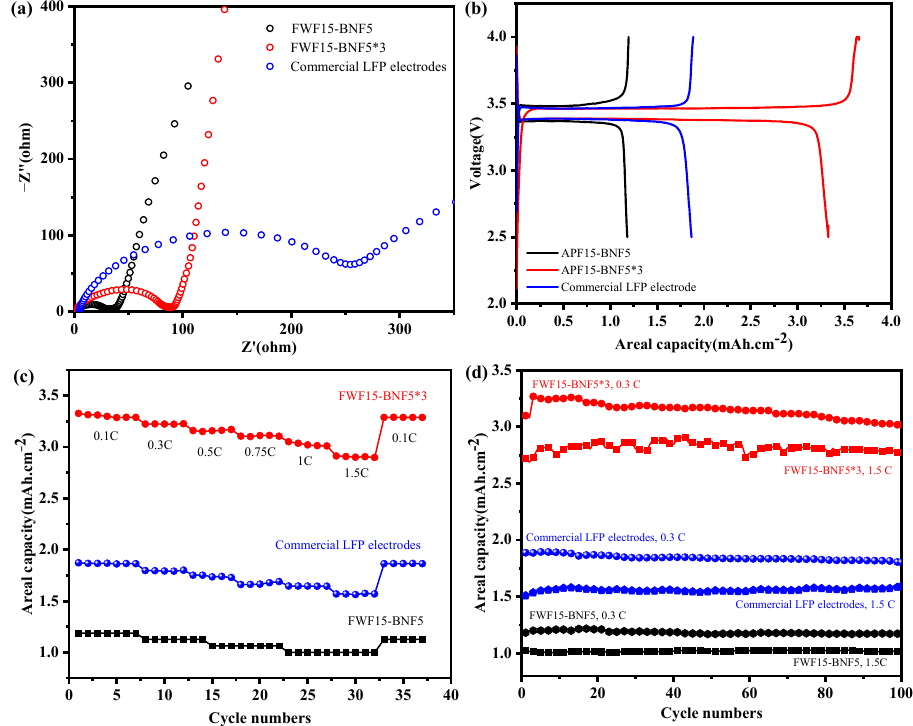
Figure 8. Electrochemical properties of paper-based electrodes. ( a ) EIS diagram of button cell assembled with each electrode material after three times activation. ( b ) First charge/discharge curve of button cell assembled with each electrode material. ( c ) Multiplicity curves of button cell assembled with each electrode material at different current densities. ( d ) Cycling performance of button cell assembled with each electrode material at different current densities.